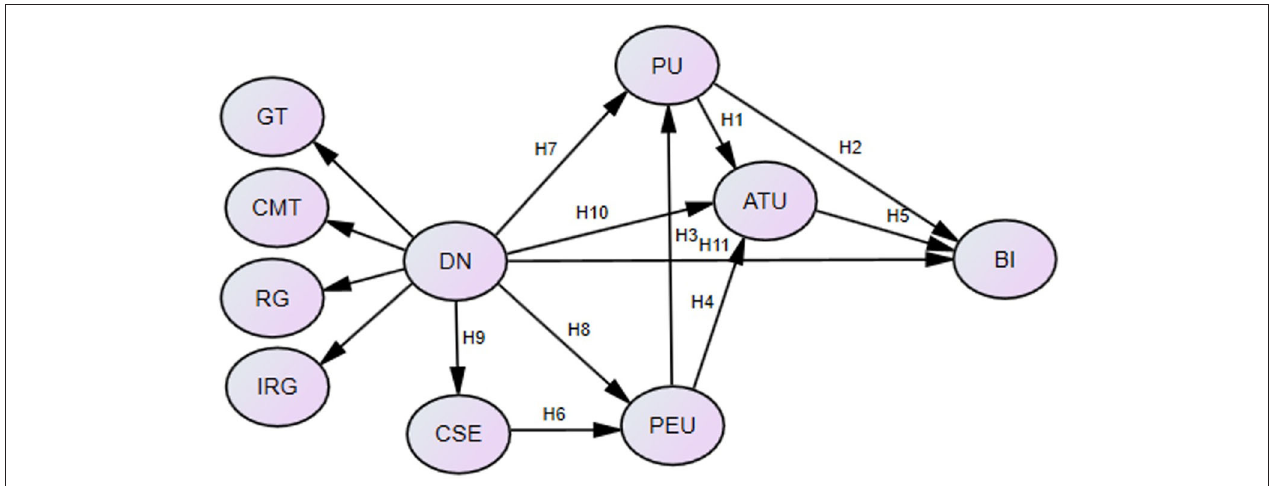
FIGURE 1 | The research model. PU, perceived usefulness; PEU, perceived ease of use; ATU, attitude; BI, behavioral intention; CSE, computer self-efficacy; DN, digital nativity; GT, grow up with technology; CMT, comfortable with multi-tasking; RG, reliant on graphics for communication; IRG, thrive on instant gratification and